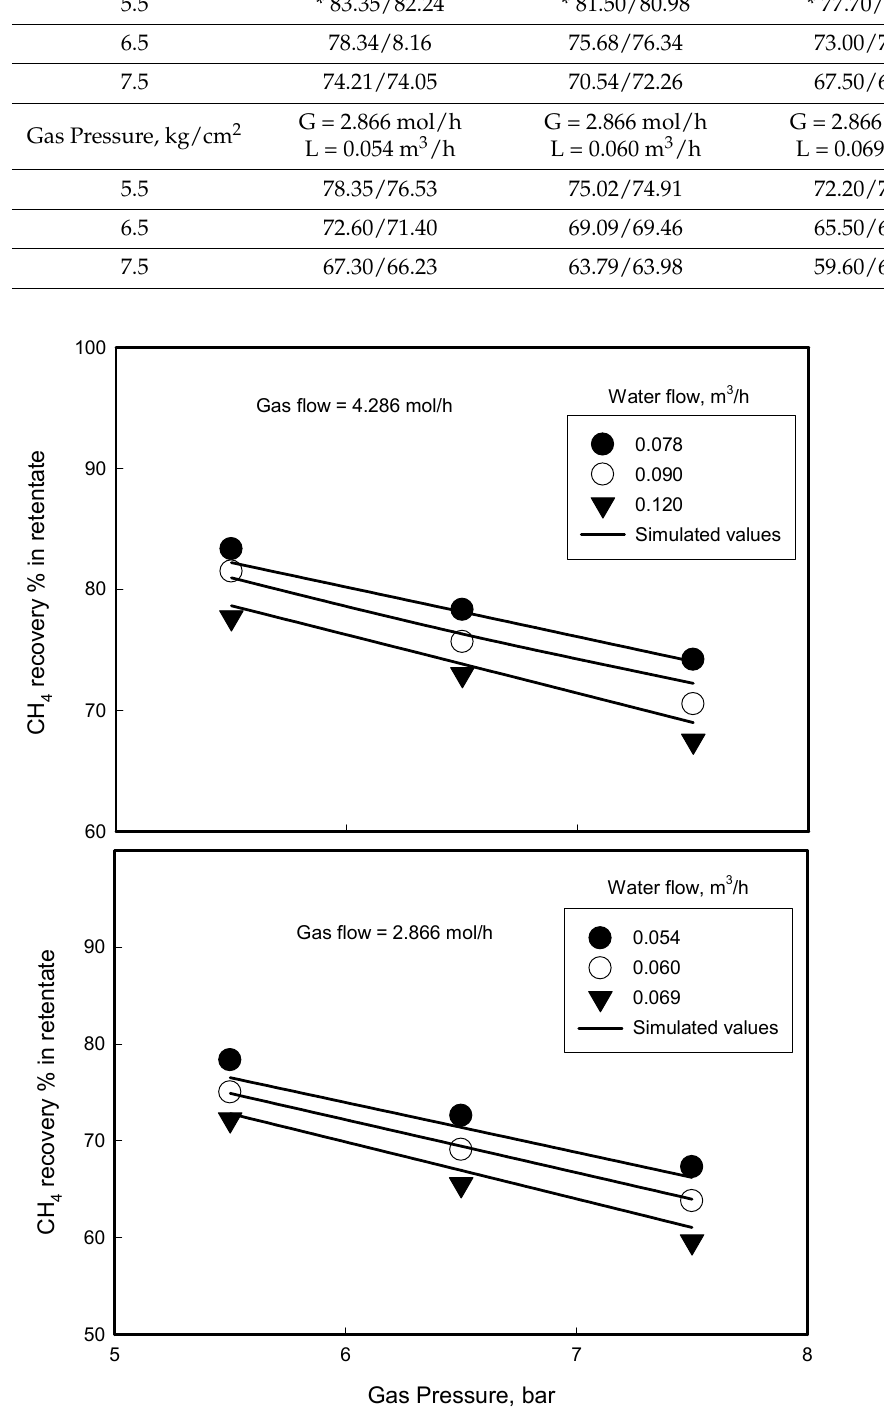
Figure 7. A comparison of simulated CH 4 recovery percent in retentate to the real experimental value in membrane contactor separation of CH 4 /CO 2 mixture at different feed gas flow rates and gas/liquid flow rate ratios.